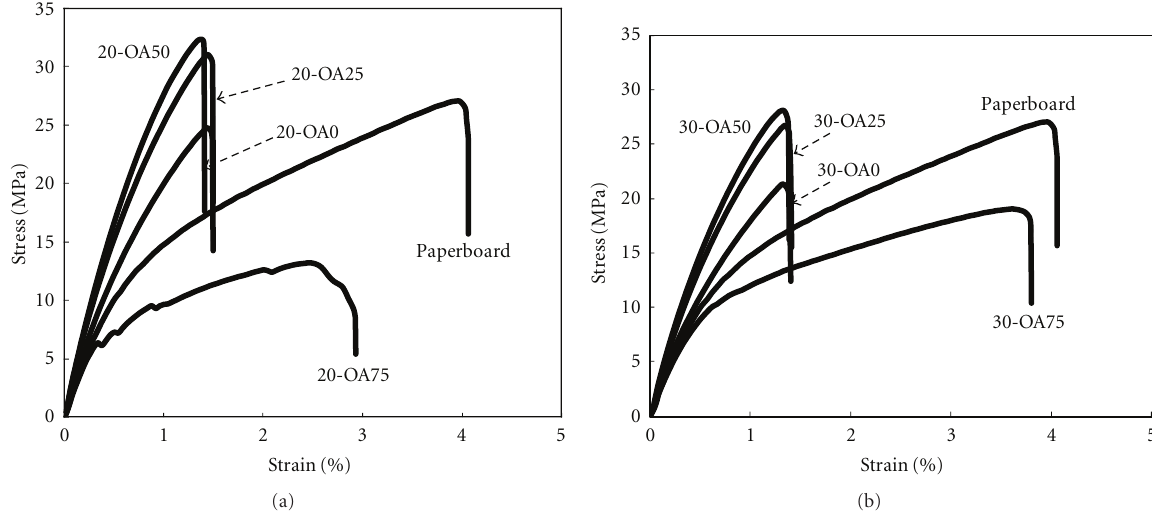
Figure 6: Stress-strain curves of the samples with (a) 20 wt.% and (b) 30 wt.% plasticizer. Note that the curves are typical examples to illustrate the trends and not the average values reported in Table